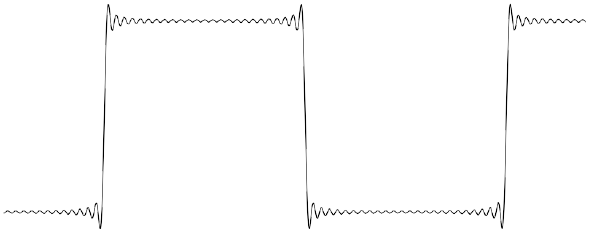
Figure 7 | Gibbs phenomenon, showing over- and undershoot, as abrupt changes undergo a sinc